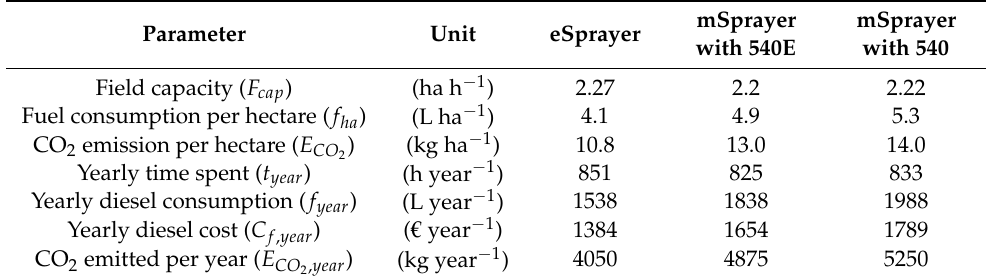
Table 14. Operational and environmental indexes with fan speed ( n f ) set at 1800 rpm. These results were calculated supposing a field area to work equal to 375 ha.